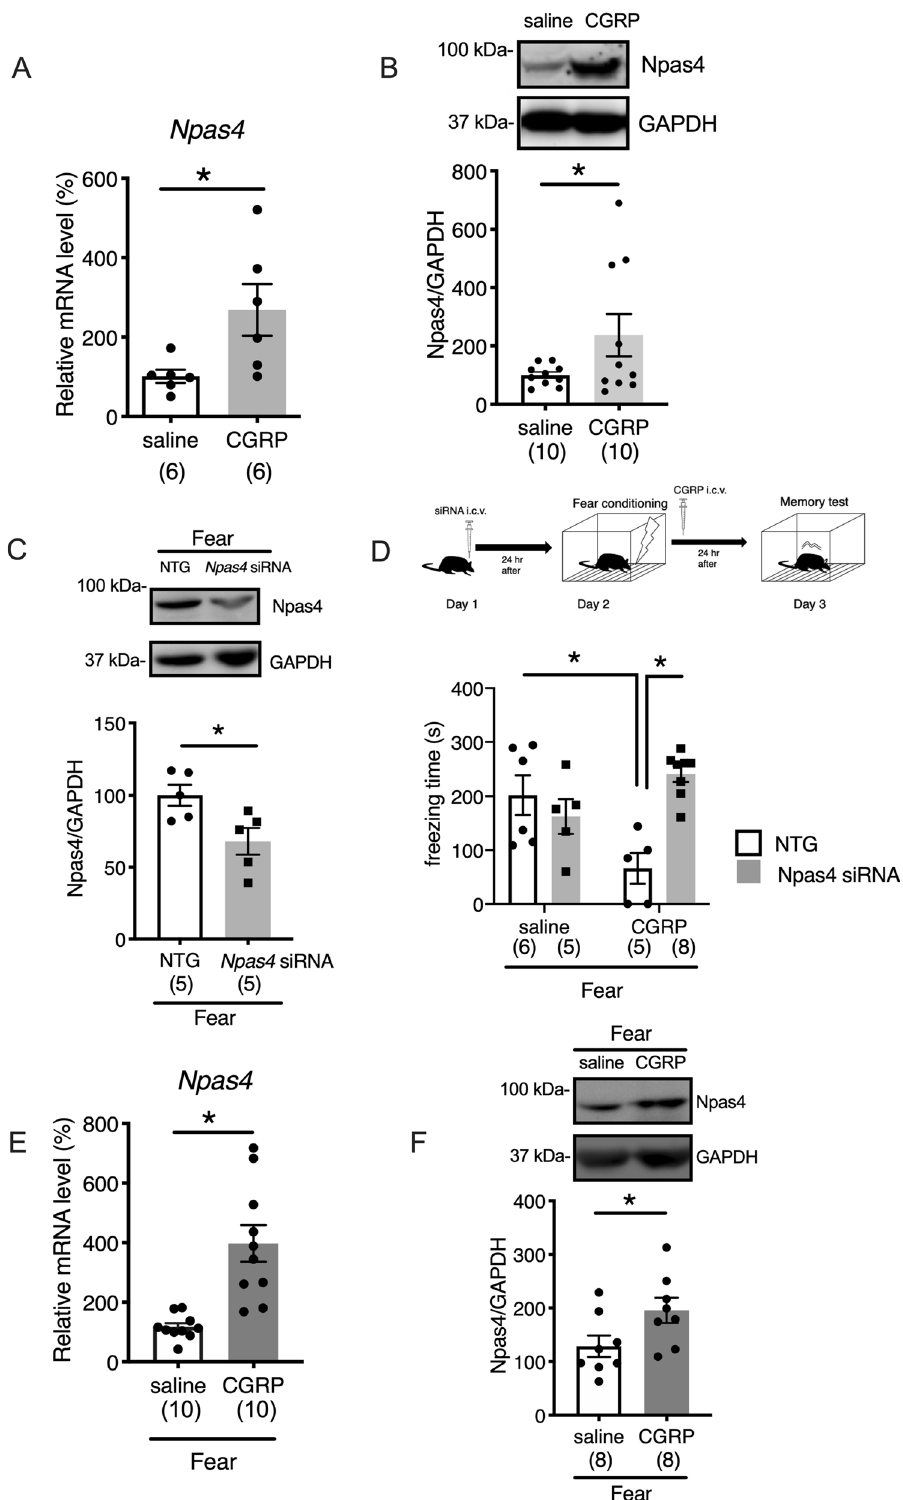
Figure 2. Npas4 is involved in the CGRP-mediated suppression of fear memory retention. ( A ) Npas4 mRNA (Welch’s t test, p = 0.0249). ( B ) Npas4 protein (Welch’s t test, p = 0.0473). ( C ) Npas4 protein expression with fear conditioning and Npas4 siRNA treatment (Welch’s t test, p = 0.0143). ( D ) Freezing time during the contextual fear learning test, after treatment with Npas4 siRNA (Two-way ANOVA, interaction, F 1,20 = 14.79, p = 0.001; CGRP, F 1,20 = 1.064, p = 0.3146; Npas4 siRNA, F 1,20 = 5.976, p = 0.0239, One-way ANOVA, F 3,20 = 7.375, with Tukey’s test). ( E ) Npas4 mRNA with fear conditioning (Welch’s t test, p = 0.0006). ( F ) Npas4 protein with fear conditioning (Welch’s t test, p = 0.0238). Each bar indicates the mean ± S.E.M. * p < 0.05. Numbers in parentheses indicate the animal numbers for each group. The full-length blots are presented in Supplementary Fig.